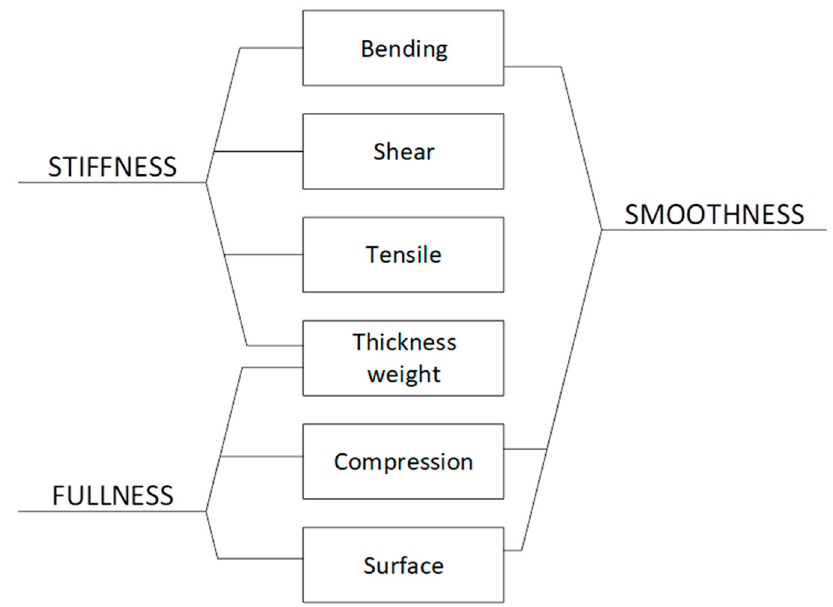
Figure 1. Diagram of linked fabric properties [adapted from 17].